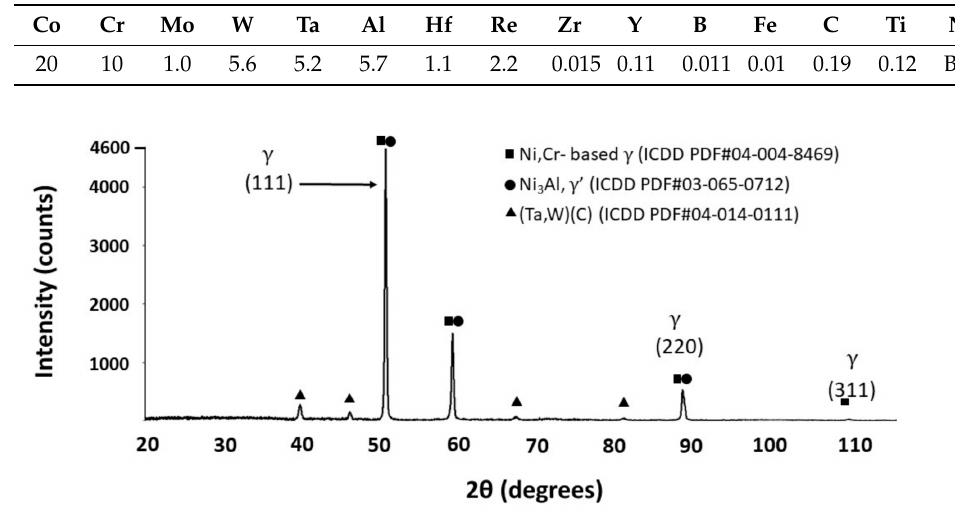
Figure 5. XRD patterns of LDEDed 4275M72 after heat treatment. The PDF numbers of matching phases are shown in